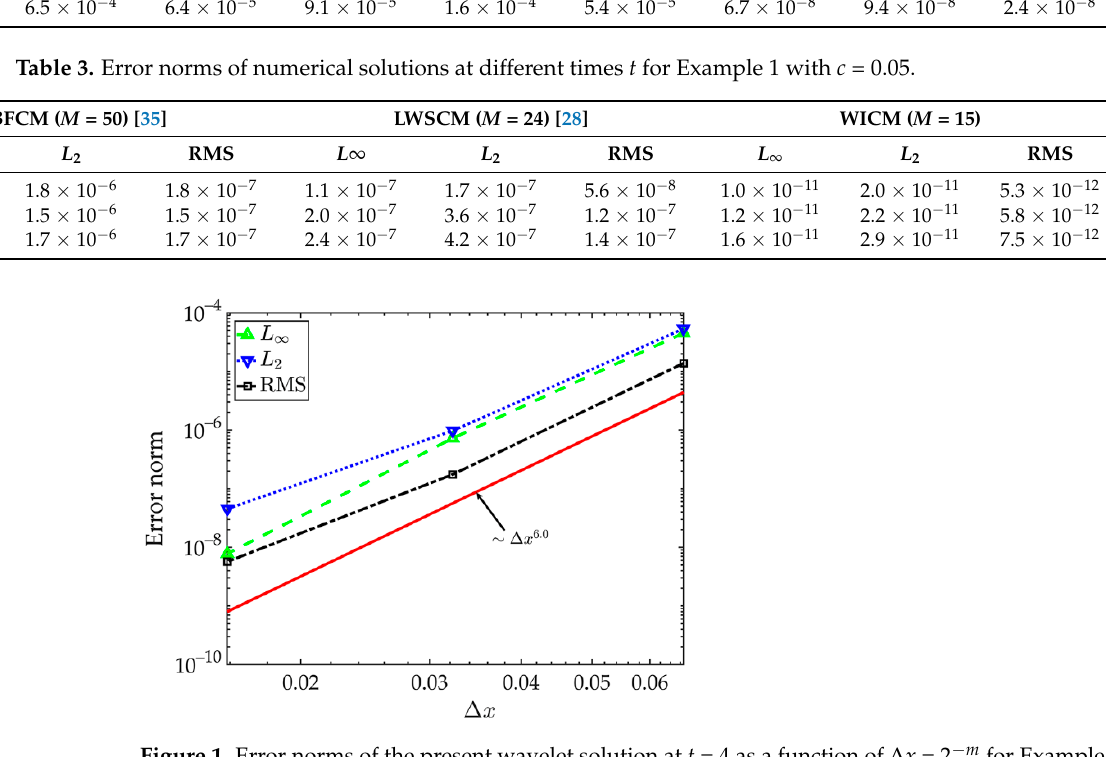
Table 4. Error norms of numerical solutions for Example 2.